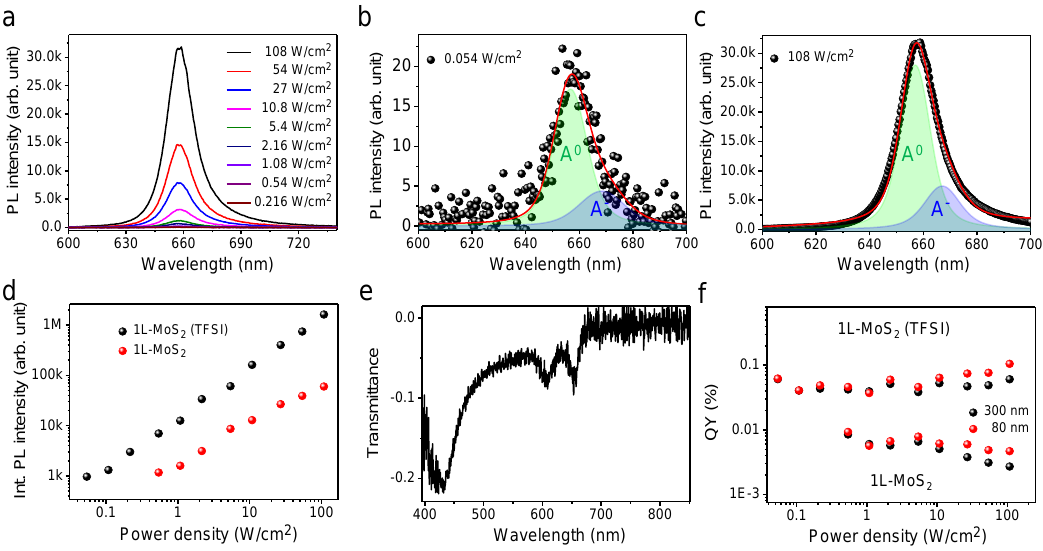
Figure 4. ( a ) Confocal PL spectra of the bis(trifluoromethane) sulfonimide (TFSI)-treated chemical vapor deposition (CVD)-grown 1L-MoS 2 on a quartz substrate with various laser intensities. Deconvoluted PL spectra of the TFSI-treated CVD-grown 1L-MoS 2 at ( b ) 0.054 W/cm 2 and ( c ) 108 W/cm 2 . ( d ) Integrated PL intensities of the TFSI-treated and pristine CVD-grown 1L-MoS 2 samples as a function of laser intensity. ( e ) Representative transmittance spectrum of the TFSI-treated CVD-grown 1L-MoS 2 . ( f ) Plot of the QYs of the pristine and TFSI-treated 1L-MoS 2 samples as a function of the laser intensity, which were estimated using 80- and 300-nm-thick reference specimens.